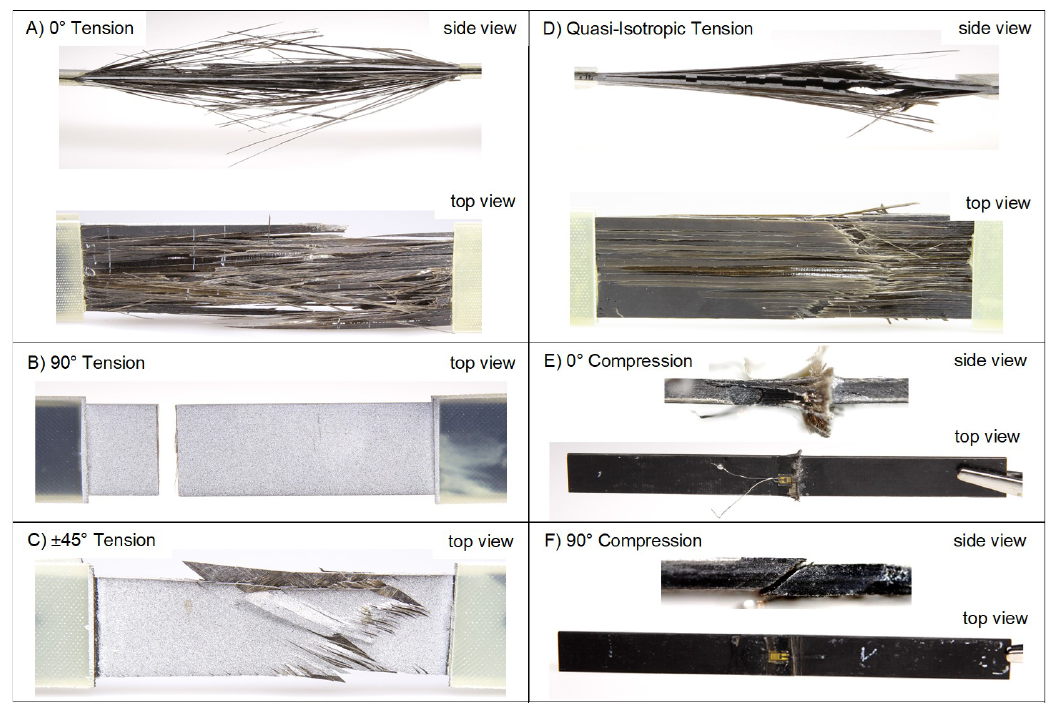
Figure 5. The different laminates exhibit characteristic failure modes: ( A ) 0 ◦ tension, ( B ) 90 ◦ tension, ( C ) ± 45 ◦ tension, ( D ) quasi-isotropic tension, ( E ) 0 ◦ compression, ( F ) 90 ◦